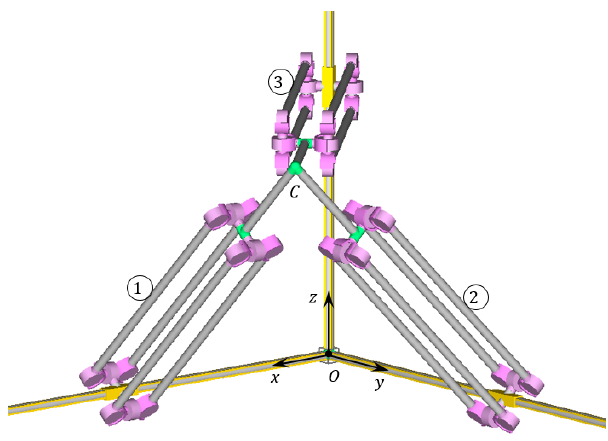
Figure 5. 3 − PPa 2 parallel